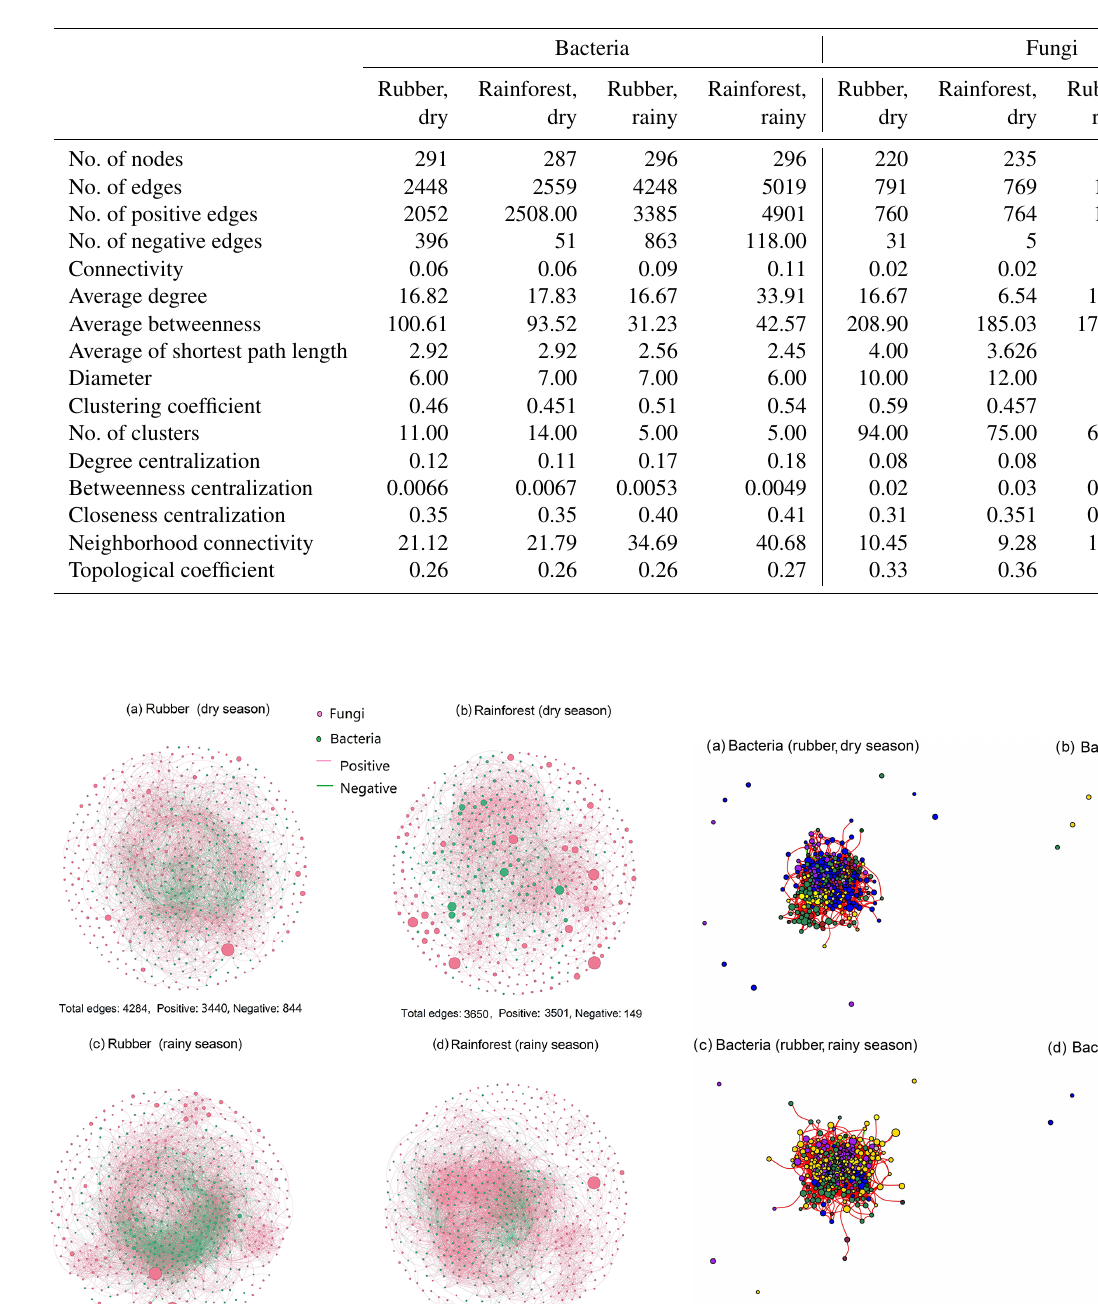
Table 1. Topological properties of the soil microbial (bacterial and fungi) network structure in a rubber plantation and tropical rainforest in the dry and rainy seasons.